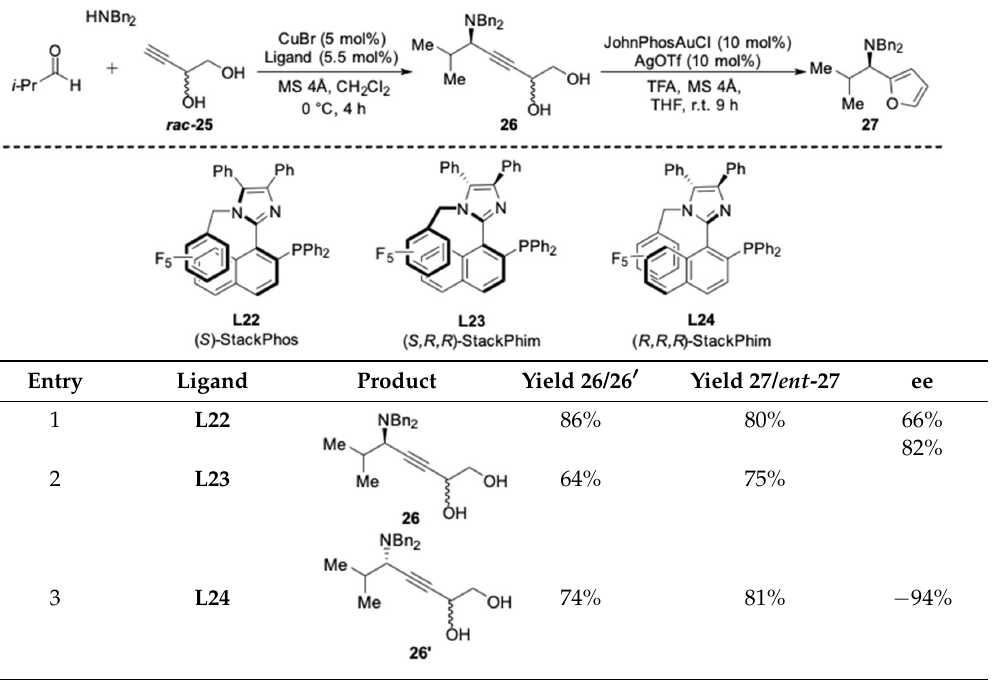
Table 4. The evaluation of StackPhim.